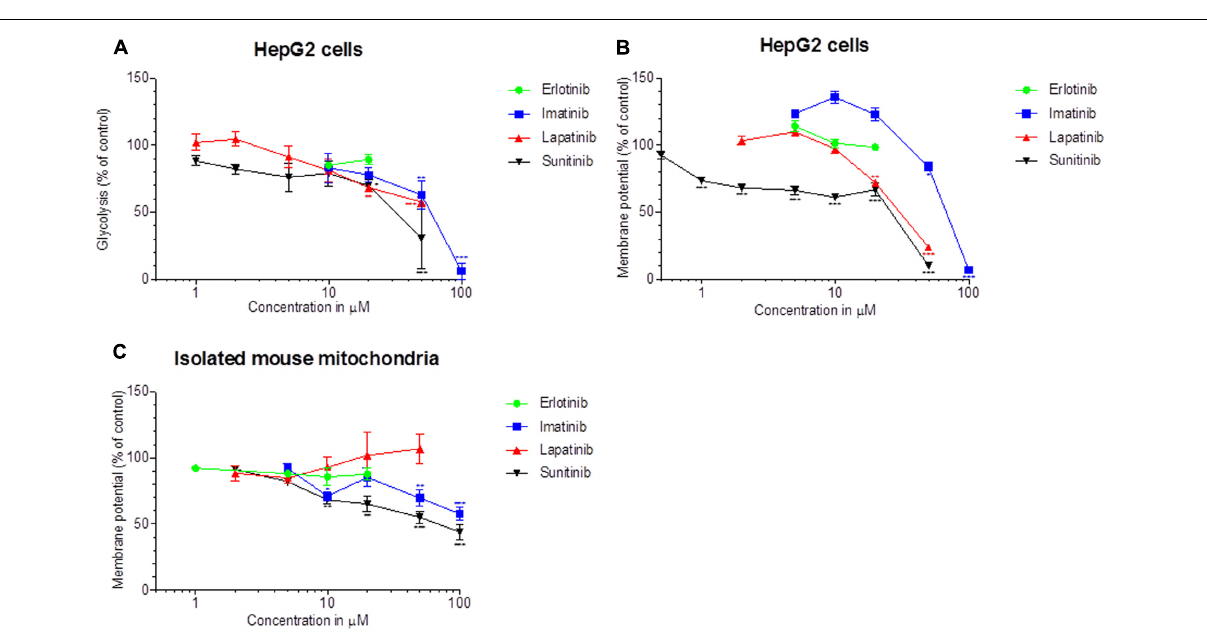
FIGURE 3 | Effect on glycolysis and on the (cid:49) ψ m . (A) Glycolysis was determined using D- 3 H(U) glucose as a substrate as described in Methods. The rate of glycolysis for the control incubations was 37.5 ± 2.6 nmoles/h/mg protein (mean ± SEM, n = 35 control incubations). (B) The (cid:49) ψ m was assessed in HepG2 cells by TMRM fluorescent staining after drug exposure for 48 h. (C) Isolated mouse liver mitochondria were labeled with [ 3 H]-tetraphenylphosphonium bromide and mitochondrial accumulation of radioactivity was determined. All data are expressed as percentage of control incubations containing 0.1% DMSO. Data represent the mean ± SEM of at least three independent experiments. ∗ p < 0.05, ∗∗ p < 0.01 or ∗∗∗ p < 0.001 versus DMSO